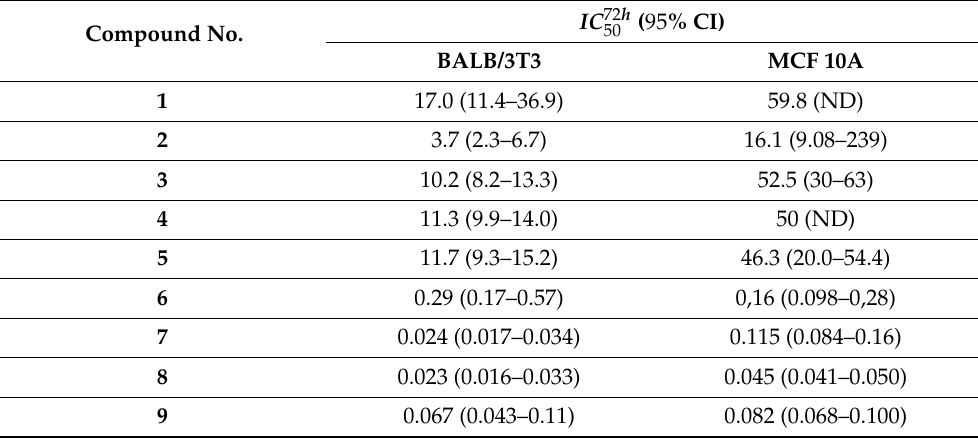
Table 3. Antiproliferative activity of the tested compounds assessed by the SRB method after 72 h of treatment in two diverse cell lines. The highest concentration used was 100 µ M. Compound